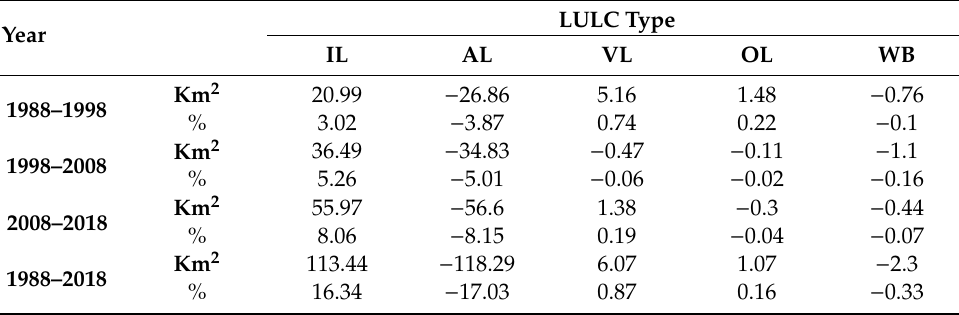
Table A3. Summary Land Use / Land Cover change statistics for Kathmandu Valley. Year